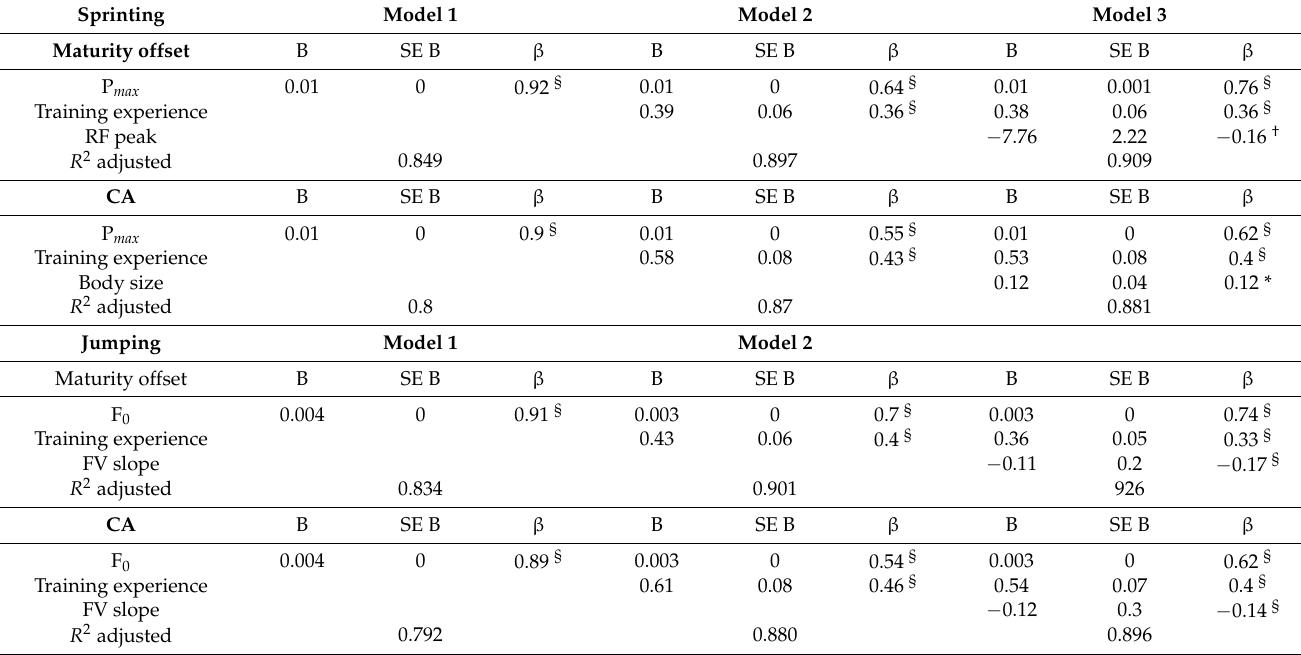
Table 4. Stepwise regression analyses relating both maturity offset and chronological age (CA) with components of force-velocity (FV) profiles in sprinting and jumping, body size, and training